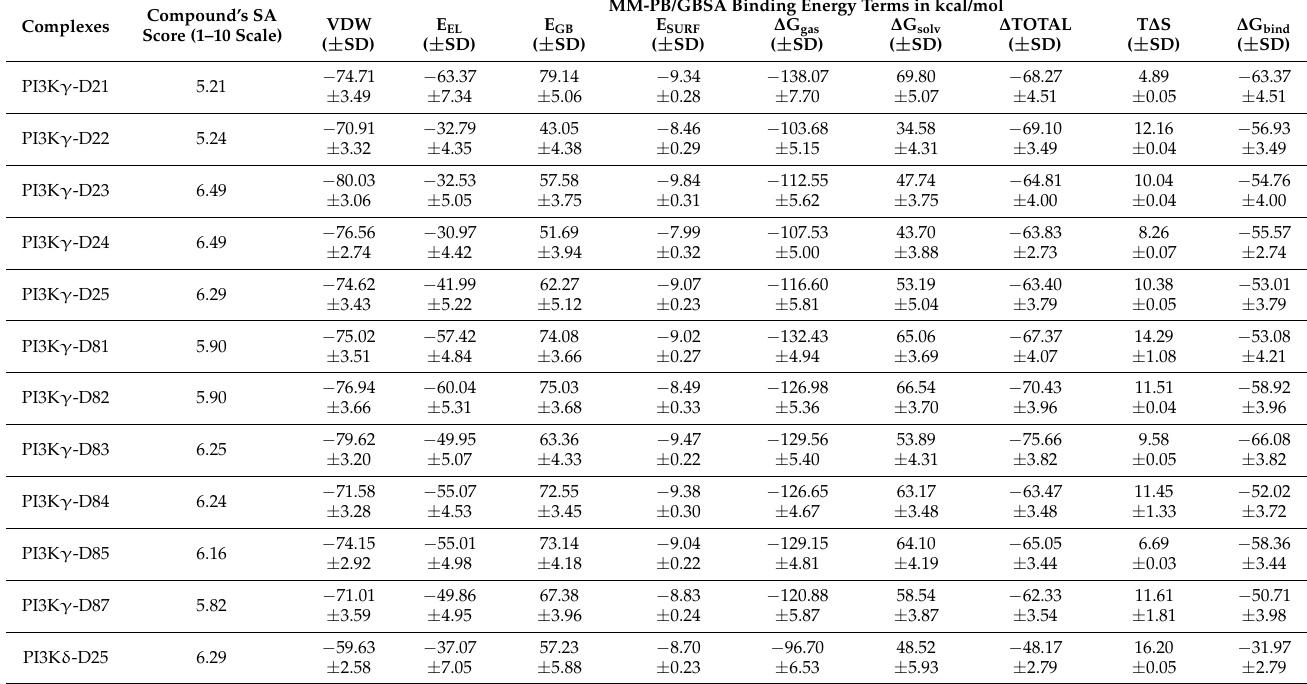
Table 12. SA score prediction and binding energy calculation of the newly designed compounds. Compound’s SA Complexes Score (1–10